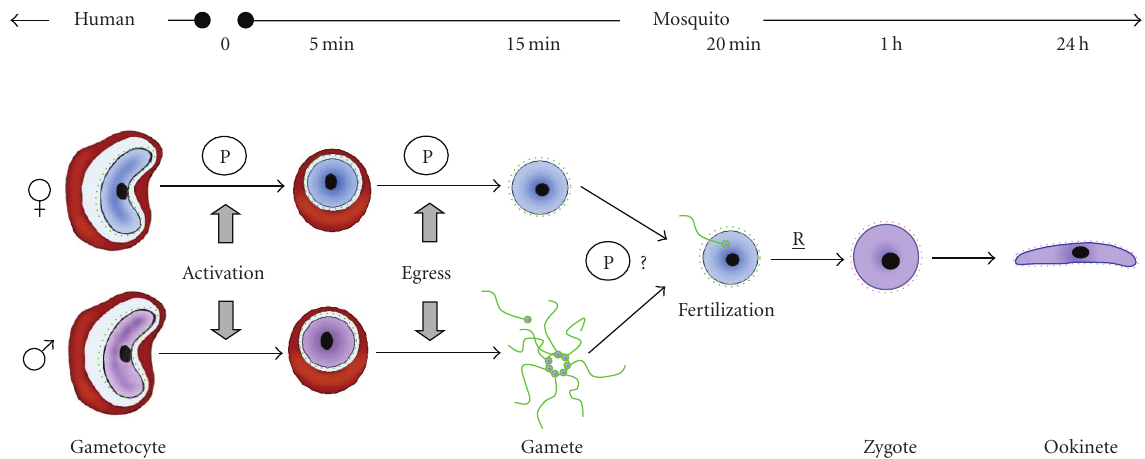
Figure 3: Morphological changes of malaria parasites during transmission from the human host to the mosquito vector. The intraerythrocytic gametocyte stages mature in the human host and are taken up by the blood-feeding female mosquito. By entering the mosquito midgut, the gametocytes become activated and round up, before emerging from the enveloping host erythrocyte. Proteases (P) are involved in these processes. During gametogenesis, the female macrogametocyte transforms into a macrogamete, while the activated male microgametocyte forms eight microgametes. Within approximately twenty-minute post-activation, the motile microgamete fertilizes the macrogamete and the resulting zygote transforms within a day into the infective ookinete. Two classes of sexual stage proteins are expressed in association with the parasite surface. A first class of proteins (shown in green) is expressed in the parasitophorous vacuole of the developing gametocyte, where some of them assemble to form adhesive multiprotein complexes. The proteins are later exposed on the surface of the newly emerged gametes, but expression ceases during fertilization. Expression of a second class of surface-associated proteins (shown in pink) is repressed in the gametocyte stage, but repression is released during fertilization (R) and protein expression persists to the ookinete